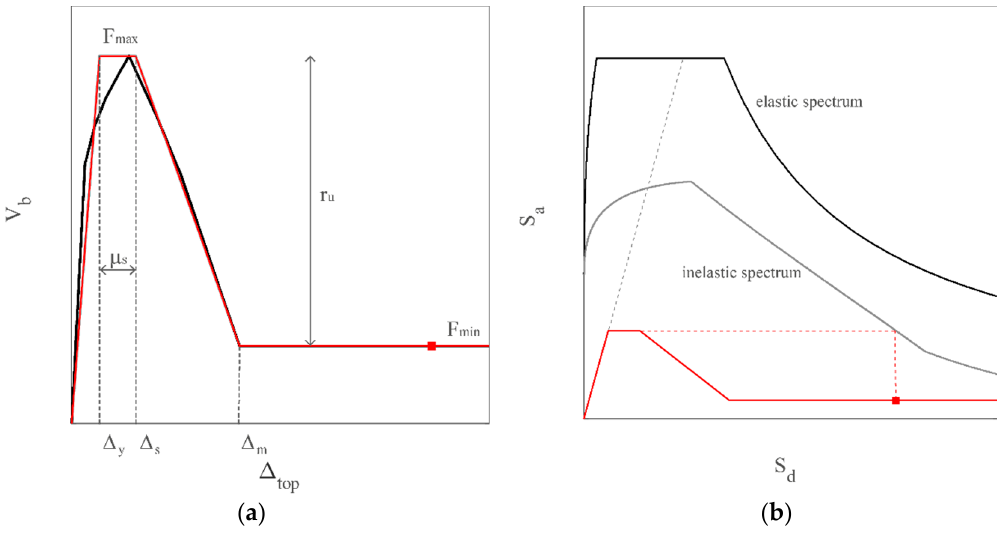
Figure 5. Pushover curve and evaluation of lateral seismic capacity with spectral approach ( a ) Pushover curve and the quadrilinear idealization according to [50]; and ( b ) the application of capacity spectrum method for evaluation of the capacity.